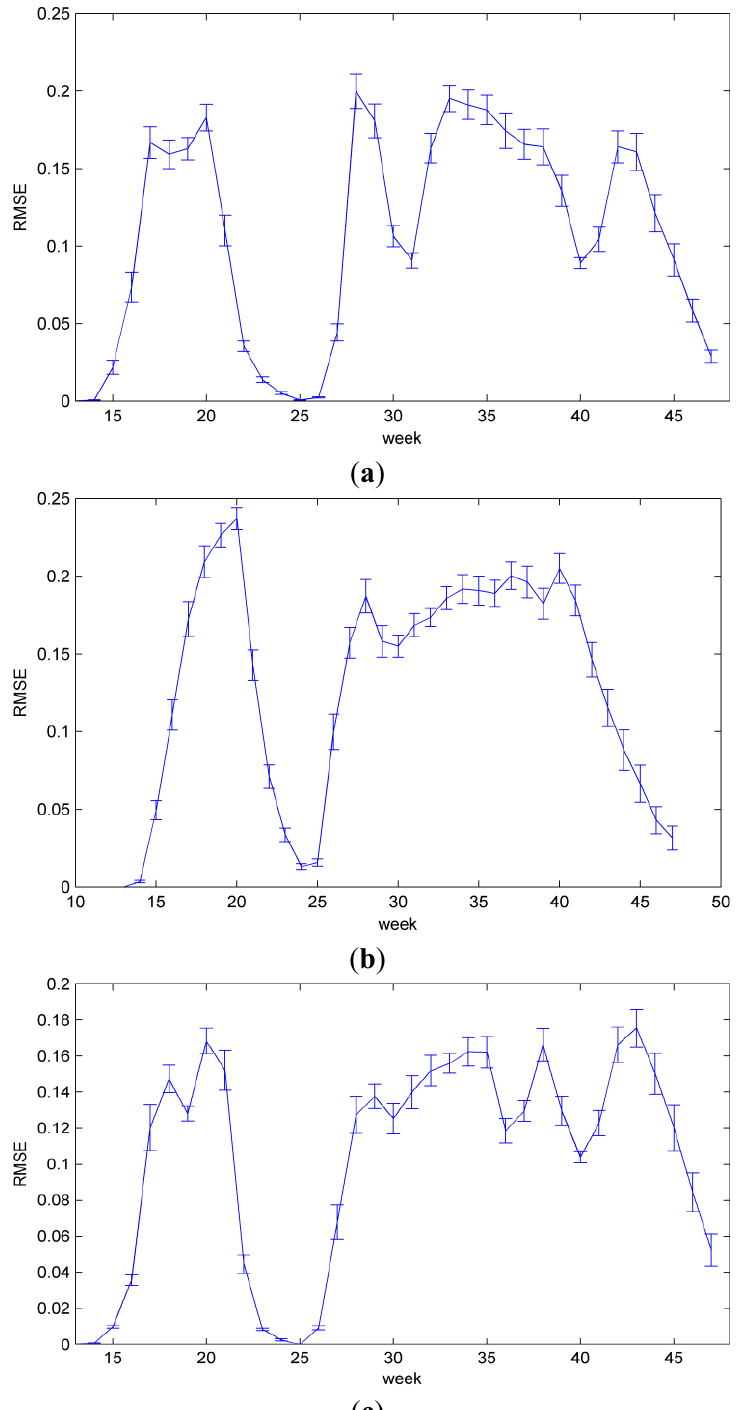
Figure 6. RMSE of corn progress percentage estimates. ( a ) Iowa; ( b ) Illinois; ( c )